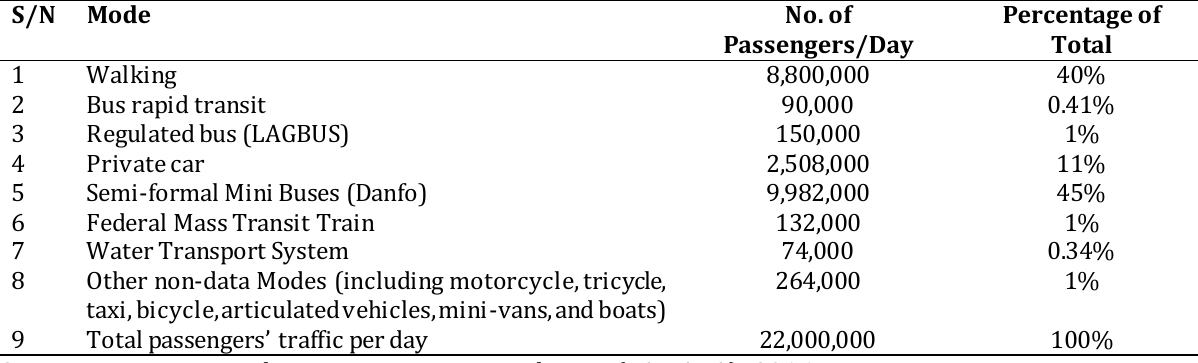
Table 1: Dominance of Danfo buses in public transport ridership share compared to other modes in